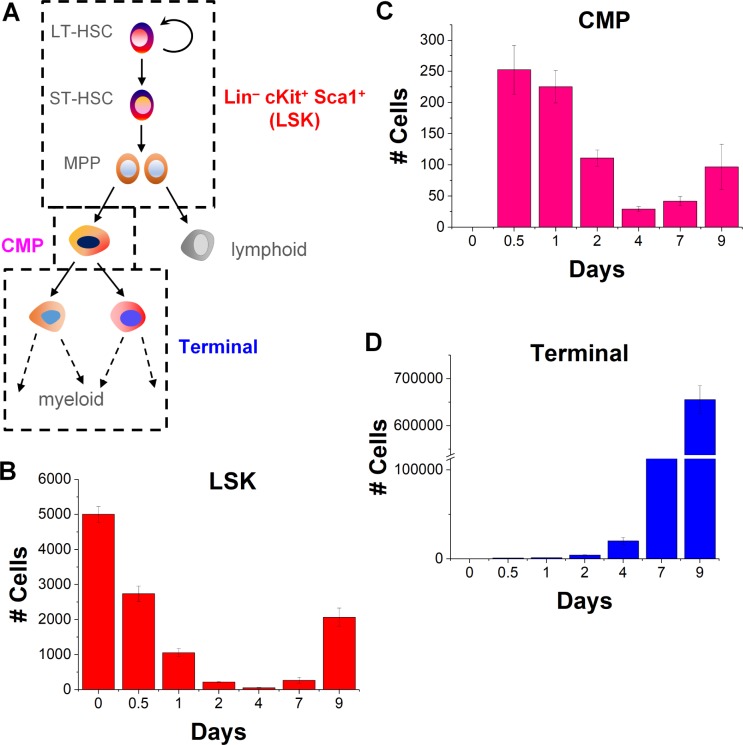
FACS analysis of cell progenitor populations over time.(A) Schematic of the classical HSC differentiation hierarchy where early progenitors (identified as LSK) differentiate into CMPs before maturing into fully developed myeloid cells (Terminal). (C-D) Total number of each cell sub-population (LSK, CMP, Terminal) in culture over time. While the LSK cells recover some of their numbers, CMP population show variable kinetics but overall low numbers, and Terminal cells grow at an exponential rate. Error bars represent standard error of mean.